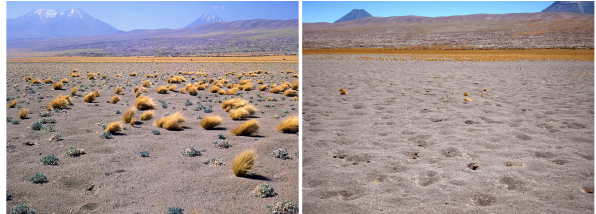
Fig. 7. Puna of Festuca grassland near Laguna Miscanti at 4100ma.s.l. While the left picture shows vivid sprouts of annual herbs and perennial grasses after the moist season in late March 1994 the right picture of the same area indicates a desolate aspect of an “overgrazed” wasteland after the tuco-tucos withdrew from the area (December